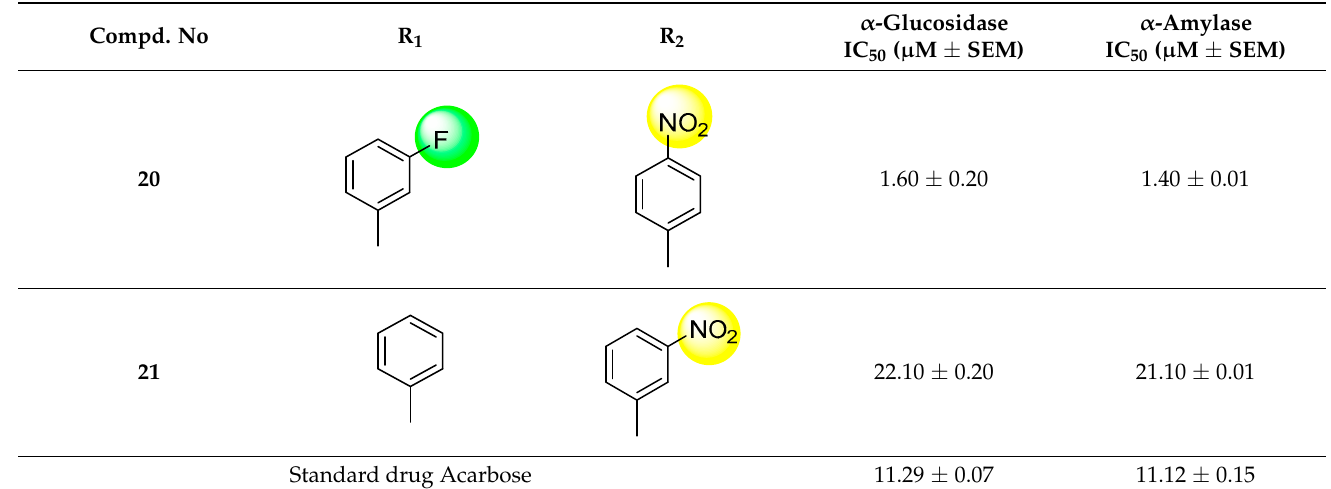
Figure 3. Structure–activity relationship of derivatives 7 , 8 and 9 . By comparing derivative 10 (IC 50 = 11.20 ± 0.10 µM) having a phenyl group at a para position on aryl ring ‘A’ and hydroxy group at a para position on aryl ring ‘B’ with deriv- atives 12 (IC 50 = 2.20 ± 0.20 µM) having two chloro groups at meta/para position on aryl ring ‘A’ and hydroxy group at a para position on aryl ring ‘B’, 16 (IC 50 = 21.10 ± 0.01 µM) having a bromo group at the para position on aryl ring ‘A’ and a hydroxy group at para position on aryl ring ‘B’. All the derivatives have the same hydroxy group on aryl ring ‘B’ but the nature of the substituent/s on aryl ring ‘A’ is different. The difference in the activity of these derivatives may be due to the different types of substituent/s attached to the aryl ring ‘A’. The activity profile of analog-6 in this regard was found to be much more potent in the presence of hydroxyl and chloro moieties, which are responsible for making strong hydrogen bonds, thus showing an excellent biological profile when compared with the standard drug acarbose (see Figure